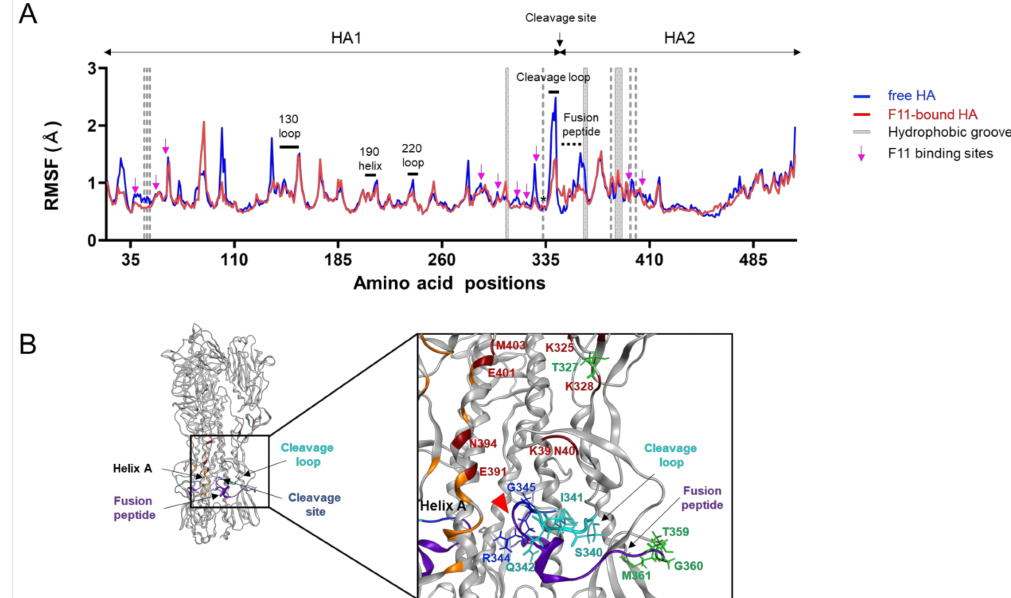
Figure 4. Effects of F11 Fab binding on the structural fluctuations of the HA ectodomain. Free and F11 Fab-bound trimeric HA ectodomains were subjected to MD simulations for 200 ns using the Amber 16 program package [23]. RMSF values of the C α atoms of individual HA residues were calculated using 10,000 snapshots during 180 to 200 ns of MD simulations as described previously [18,31,32]. ( A ) Distributions of RMSF in HA. Numbers on the horizontal axes indicate positions in the HA of influenza A/Narita/1/2009 (H1N1)pdm09 [19]. Magenta arrows indicate the residues contacting F11 Fab during 180 to 200 ns of MD simulations of the top-2 binding mode. The gray shadows indicate locations of HA residues constituting the hydrophobic groove. Regions involved in sialic acid binding [63,64], such as the 130 loop, 190 helix, and 220 loop, are merged with black bars. ( B ) Structure around the proteolytic cleavage loop. The cleavage loop, fusion peptide [64], and hydrophobic groove [53,54] are shown in cyan, purple, and orange, respectively. A red arrowhead indicates the cleavage site. Residues that noncovalently interacted with the F11 Fab fragment during MD simulation are marked with a wine red color.